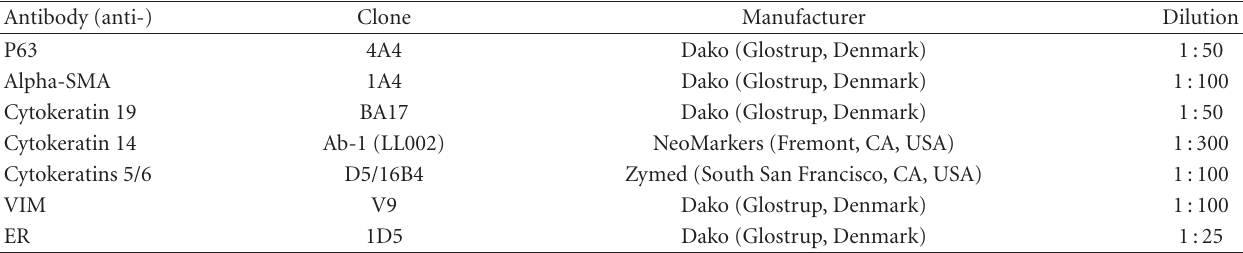
Table 1: Primary antibodies, resources, and dilutions used in immunohistochemistry.